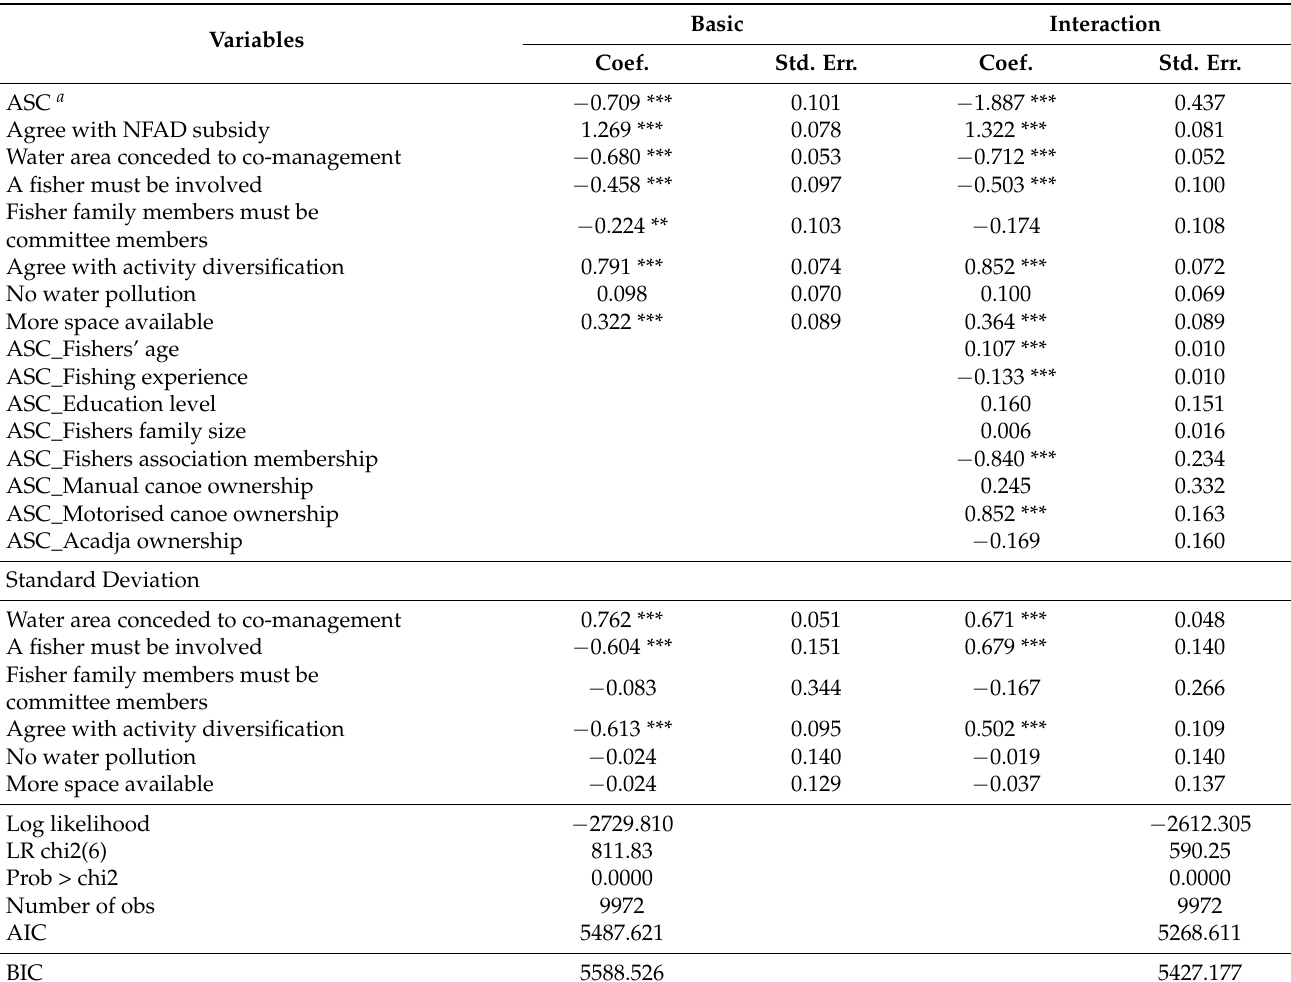
Table 6. Mixed logit results ( a = ASC (status quo) is current management practices (1 if the respondent chooses the status quo and 0 otherwise). **, *** indicate statistical significance at 5, and 10 percent levels,